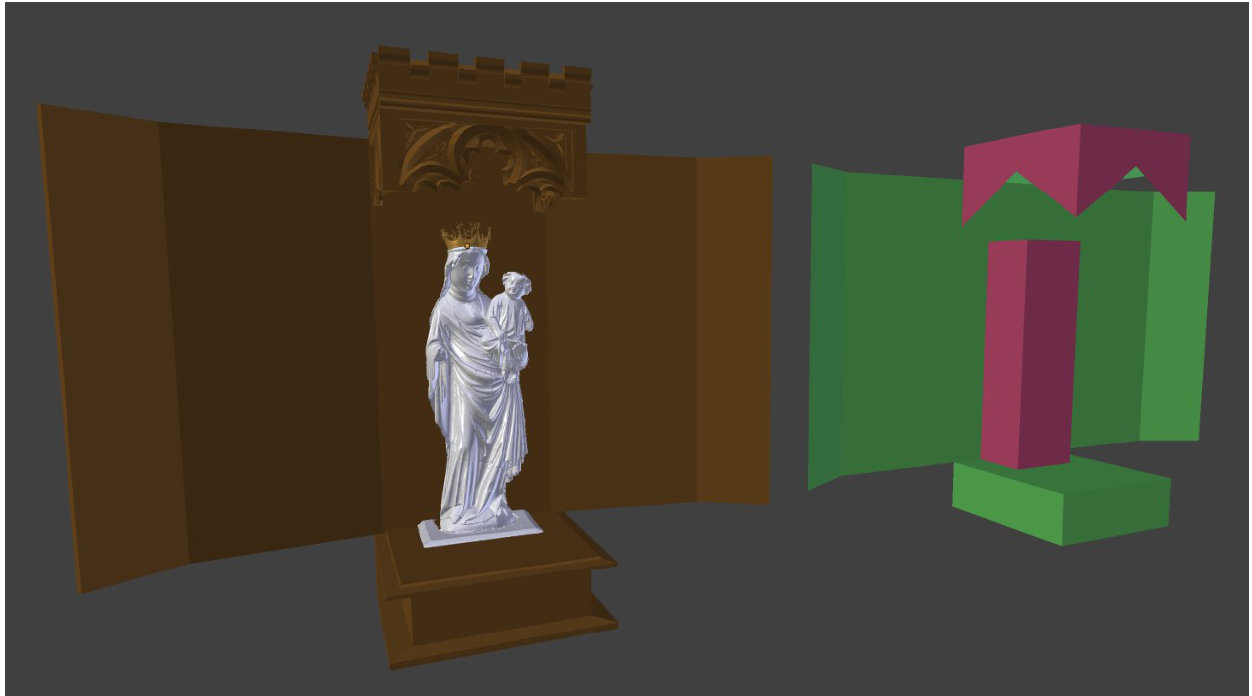
Figure 7. Simplification of statues from the visual model to the acoustic model. Screenshot from Google